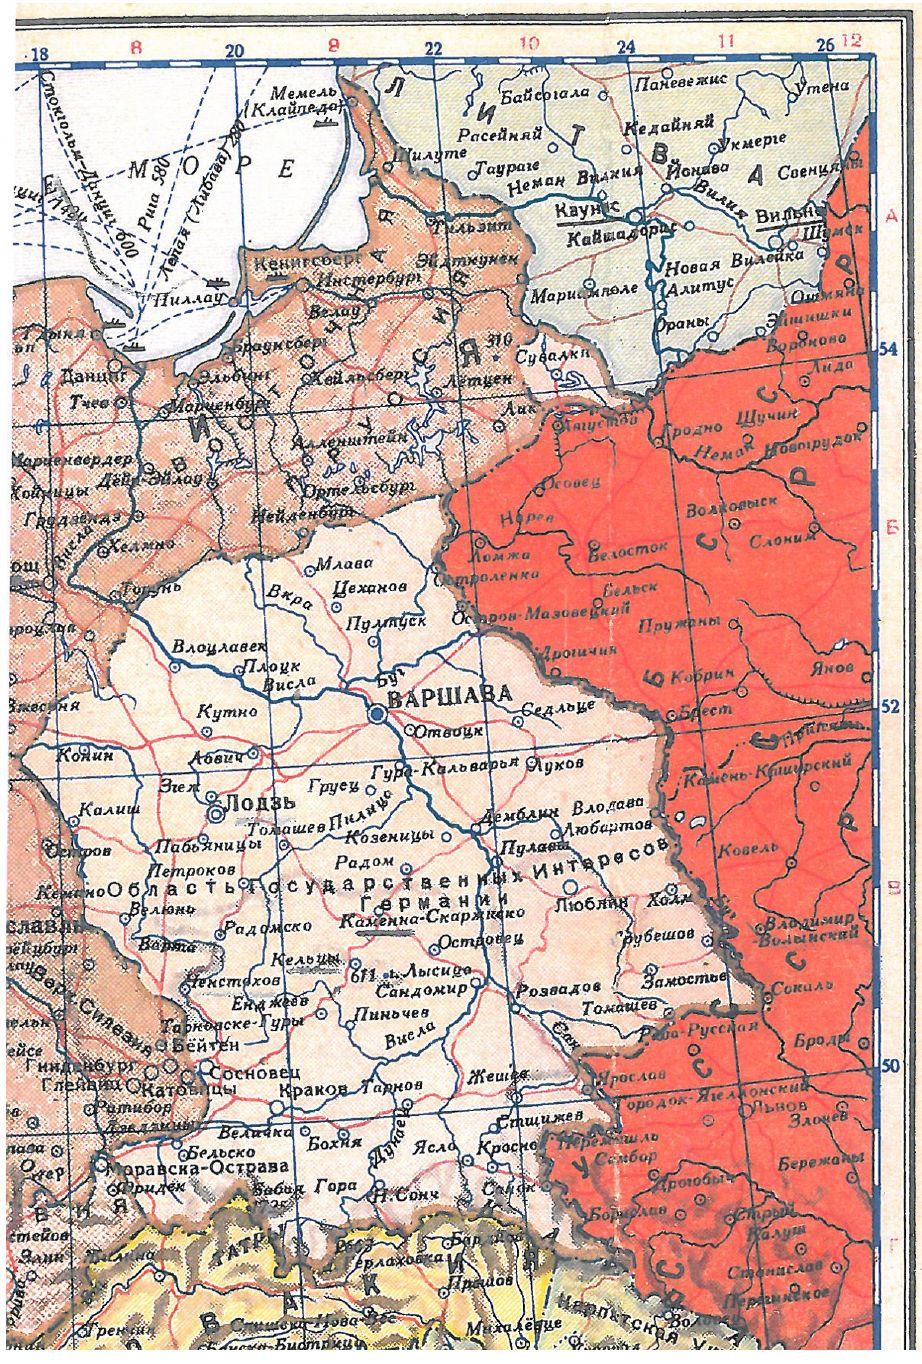
Fig. 2. Great German Reich (eastern part of the